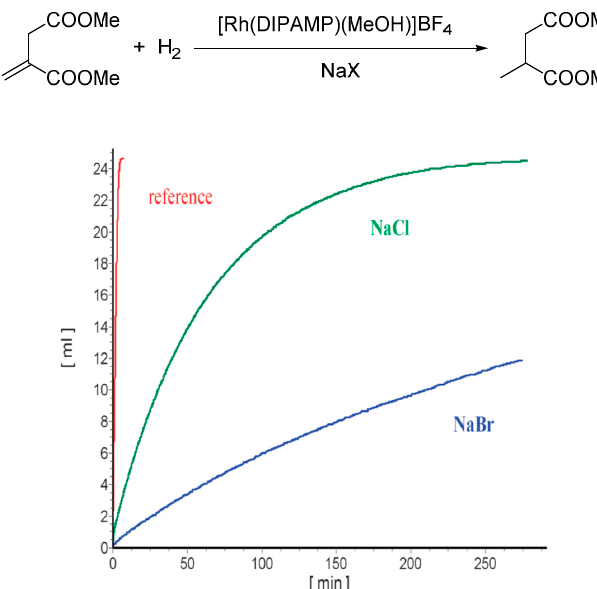
Figure 22. Hydrogen consumption (ml) for the hydrogenation of 1.0 mmol dimethyl itaconate with 0.01 mmol [Rh(DIPAMP)(MeOH) 2 ]BF 4 under addition of di ff erent sodium halides NaX: red: no additive (88% ee); green: 0.1 mmol NaCl, (82% ee); blue: 0.1 mmol NaBr, (80% ee); conditions: each 15 mL MeOH at 20 ◦ C and 1 bar total pressure.